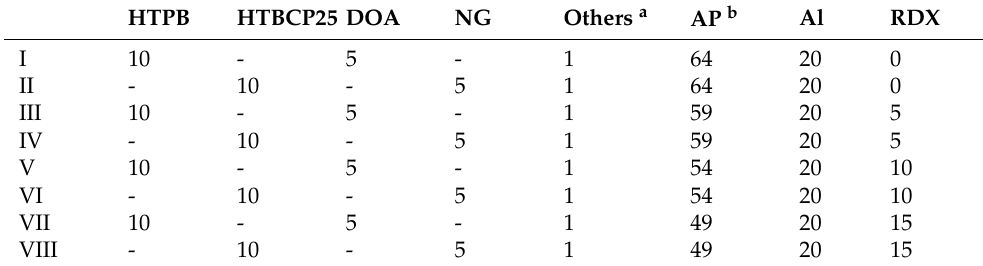
Table A1. Compositions of propellants [29].